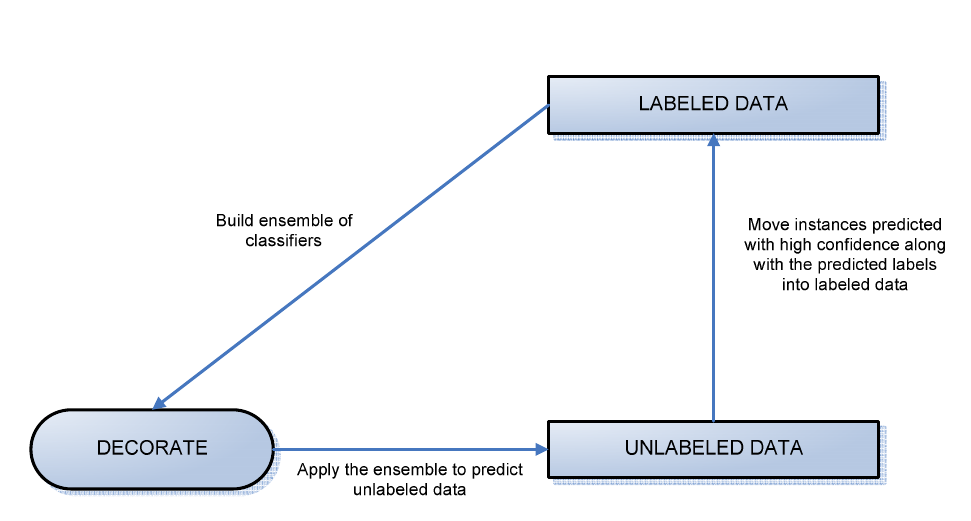
Figure 3. A diagram of the labeling